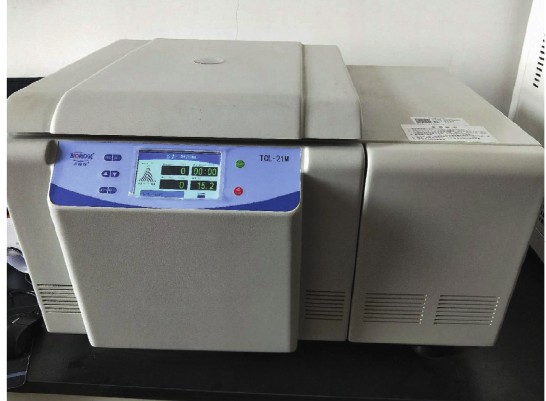
Figure 5: The porosity marking.